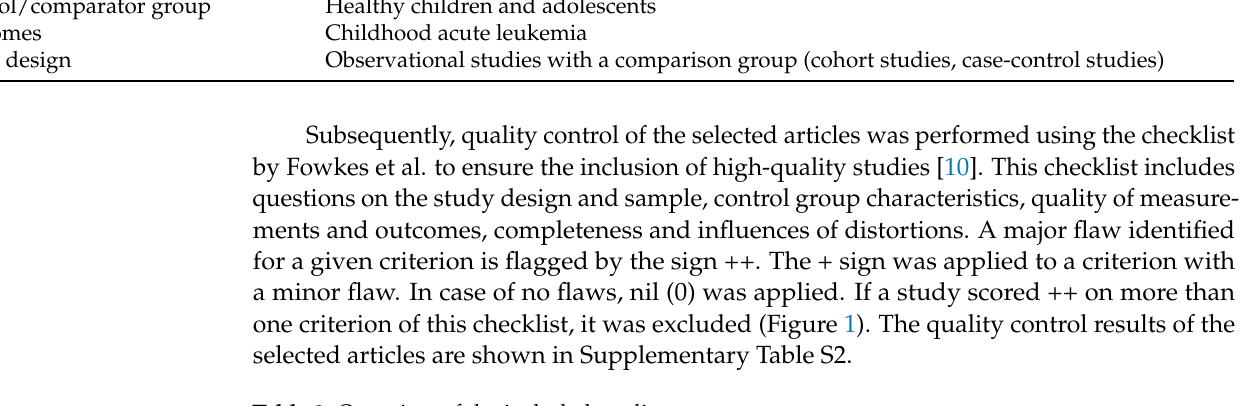
Table 3. Overview of the included